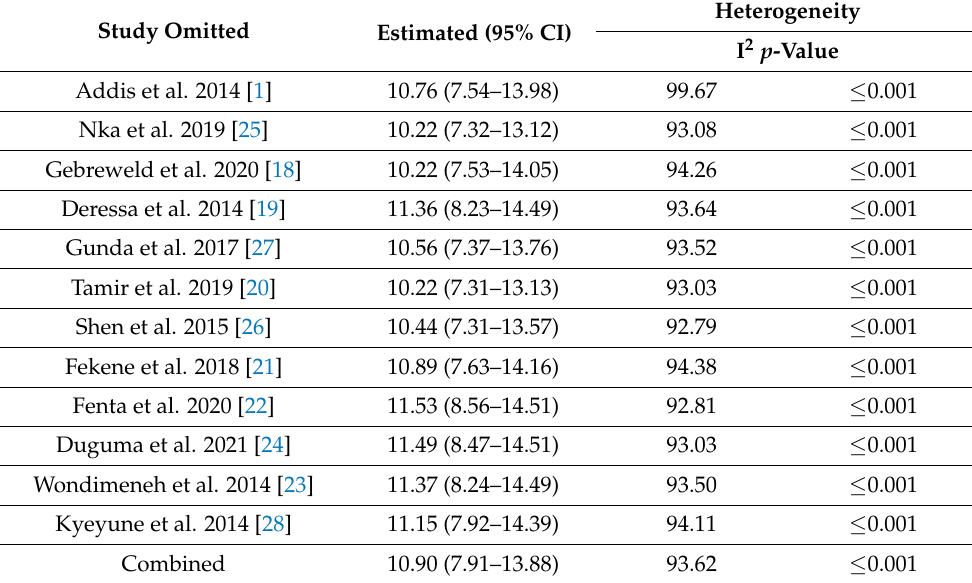
Table 2. Sensitivity analysis of the included studies to estimate the pooled thrombocytopenia in HIV